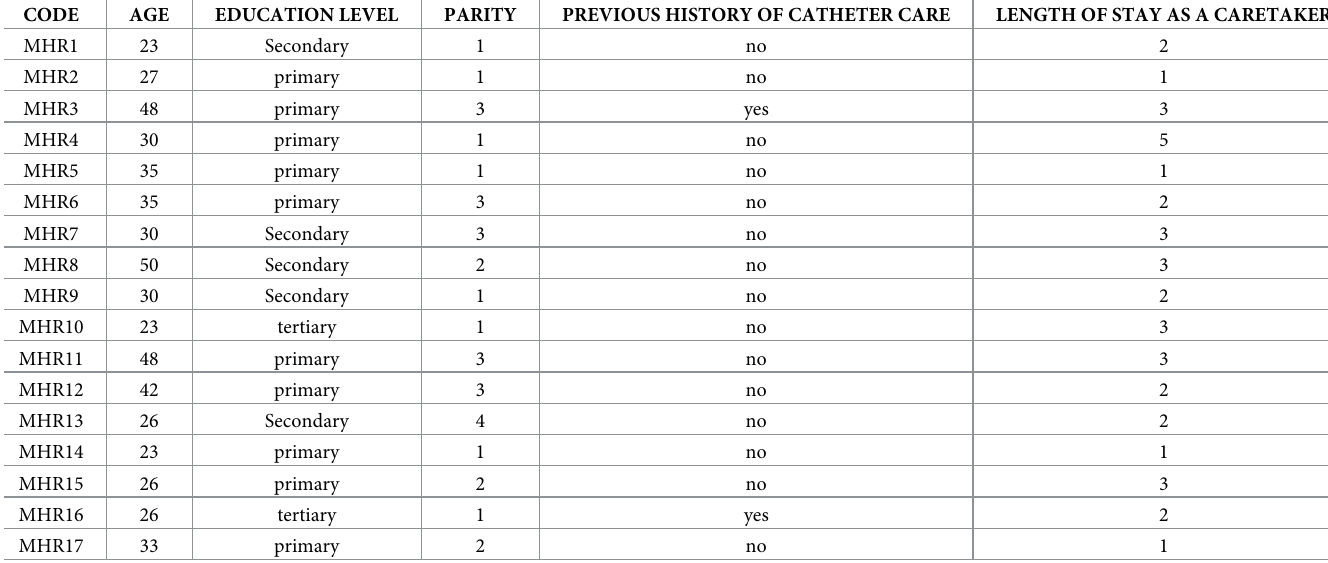
Table 6. Showing demographic characteristics of persons in charge of indwelling urinary catheter maintenance care (care-takers and postpartum mothers). CODE